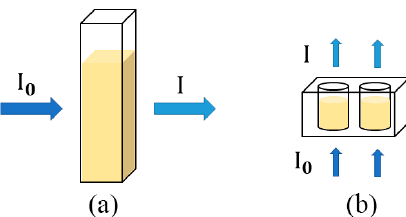
Figure 2. Differences of the UV–Vis spectrophotometer system and the microtiter plate reader system. ( a ) a cuvette used in the benchtop spectrophotometer and ( b ) a microtiter plate used in the microtiter plate reader system. I 0 and I indicate the optical intensities before and after detection, respectively.